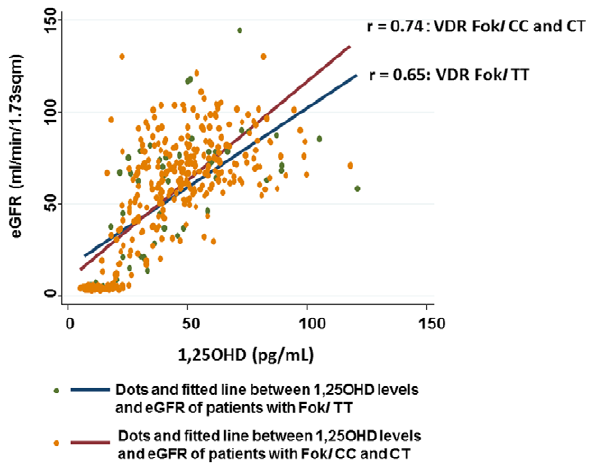
Figure 4. Two-way scatter graph for eGFR vs. 1,25OHD, stratified by patients with Fok I TT and with Fok I CC or CT. Fitting curves were drawn by calculating the prediction for eGFR from a linear regression of eGFR on 1,25OHD either in patients with Fok I TT and with Fok I CC or CT using STATA ver. 12.0.